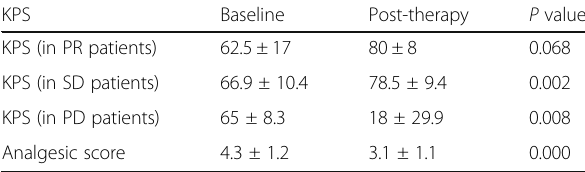
Table 3 KPS and analgesic scores pre- and post-PRRT KPS